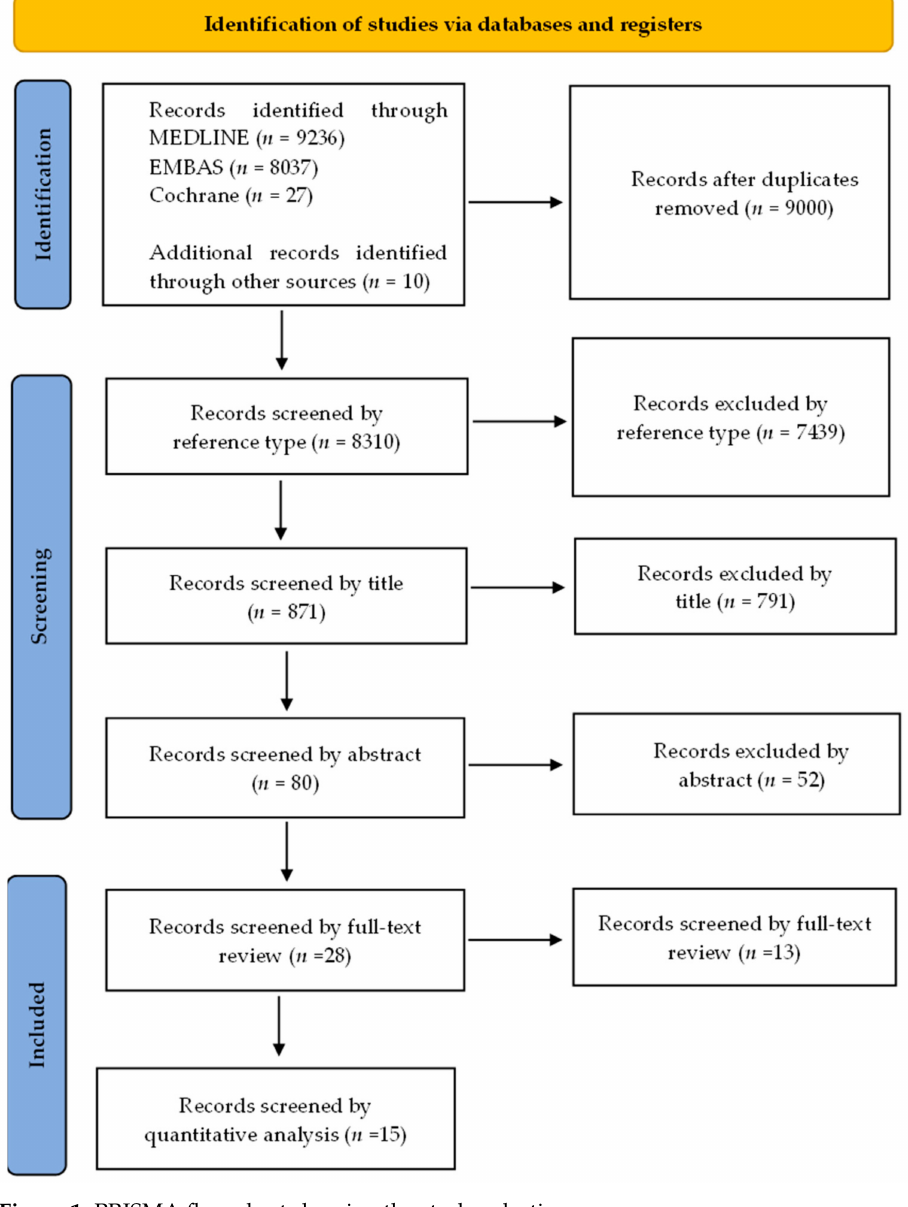
Figure 1. PRISMA flow chart showing the study selection